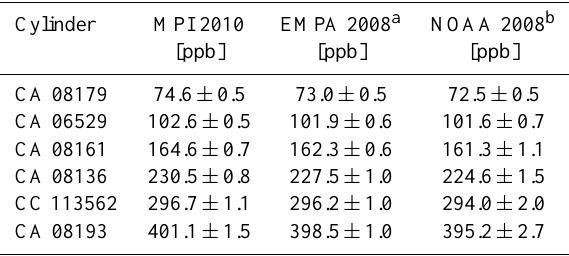
Table 1. Results of a round-robin experiment with EMPA (Switzer- land) and NOAA (US). The MPI instrument was calibrated with a standard of 155.8 ± 0.5ppbv which was referenced to the EMPA standard cylinder CA06490 with 352.5ppbv CO. The MPI results are reported with expanded uncertainty resulting from the standard deviation of the individual measurements and the uncertainty of the MPI